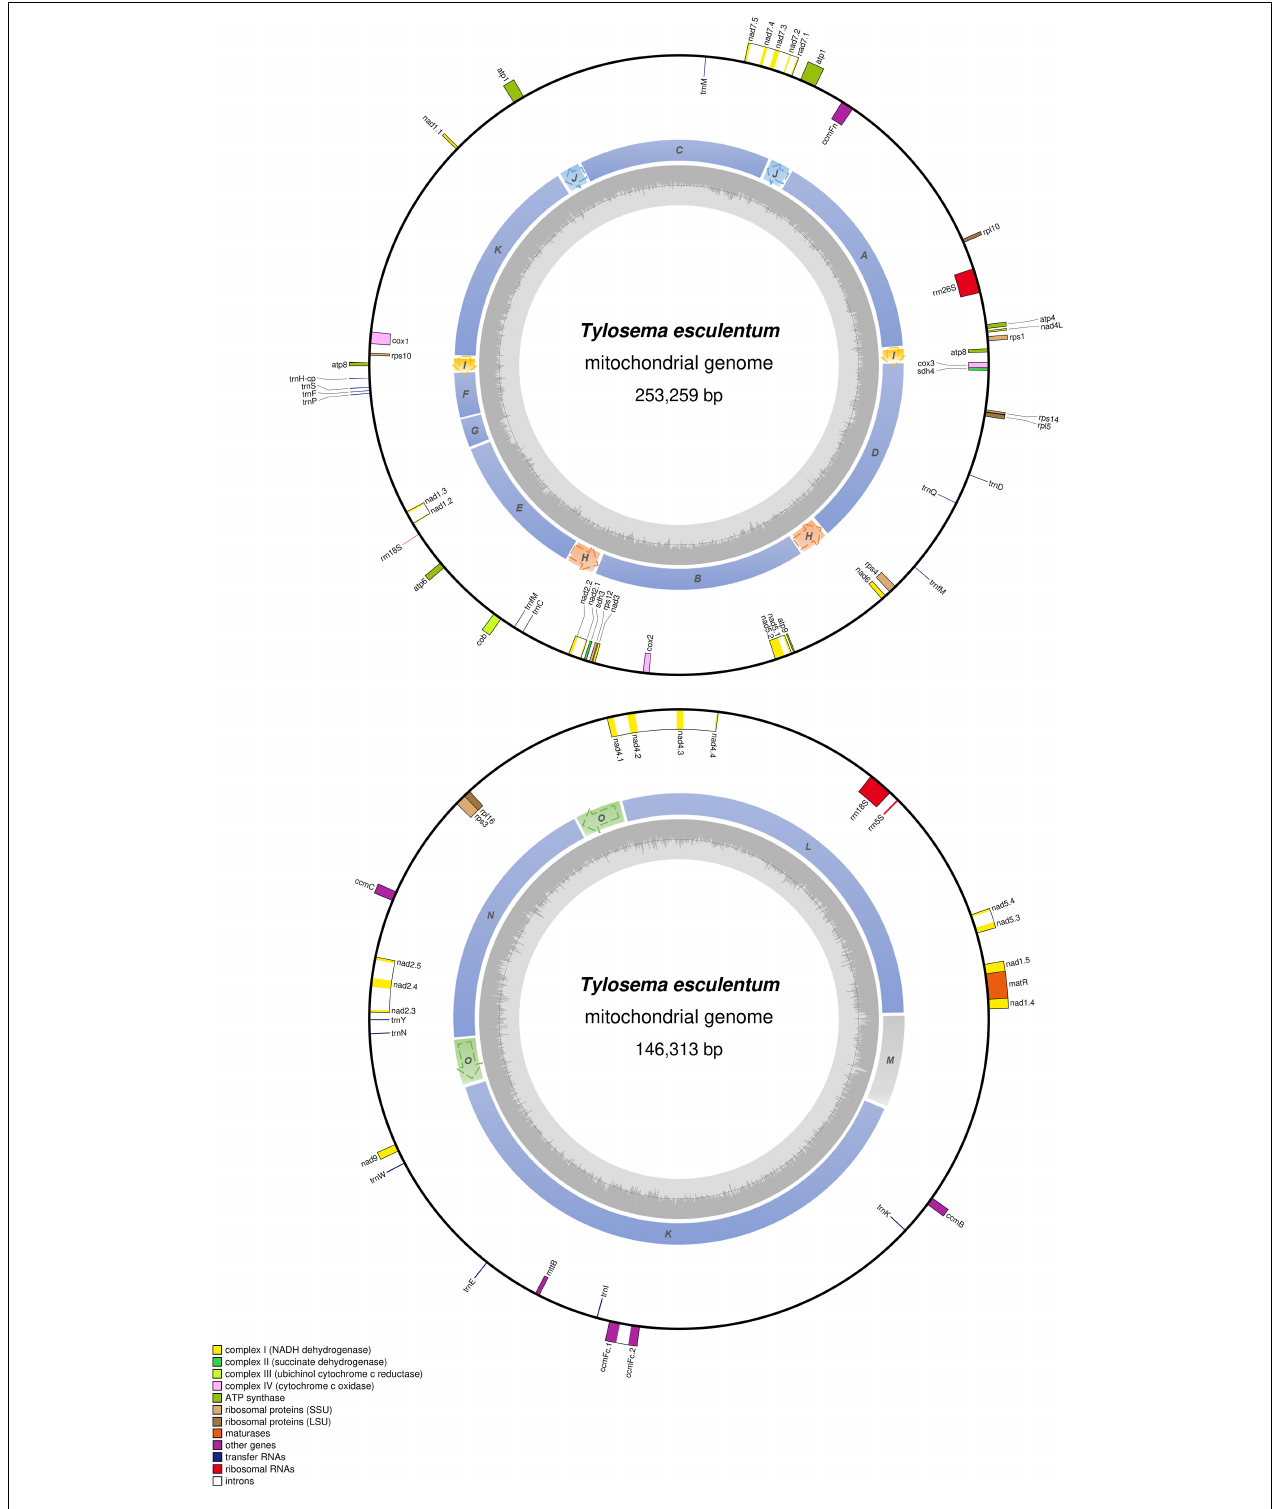
FIGURE 4 | Circular gene map of the two large molecules, LS1 (top) and LS2 (bottom) in the mitochondrial genome of T. esculentum. Genes outside the circle are transcribed clockwise, while genes inside are transcribed counterclockwise. The sequential order of exons is displayed by the decimal after the gene name abbreviation. Genes belonging to different functional groups are color-coded as shown at bottom left. Colors in the inner circle indicate the position of the structural units and repeats listed in Figure 3 . The dashed arrows represent the direction of the repeats. GC content is represented by the gray shade in the inner circle.